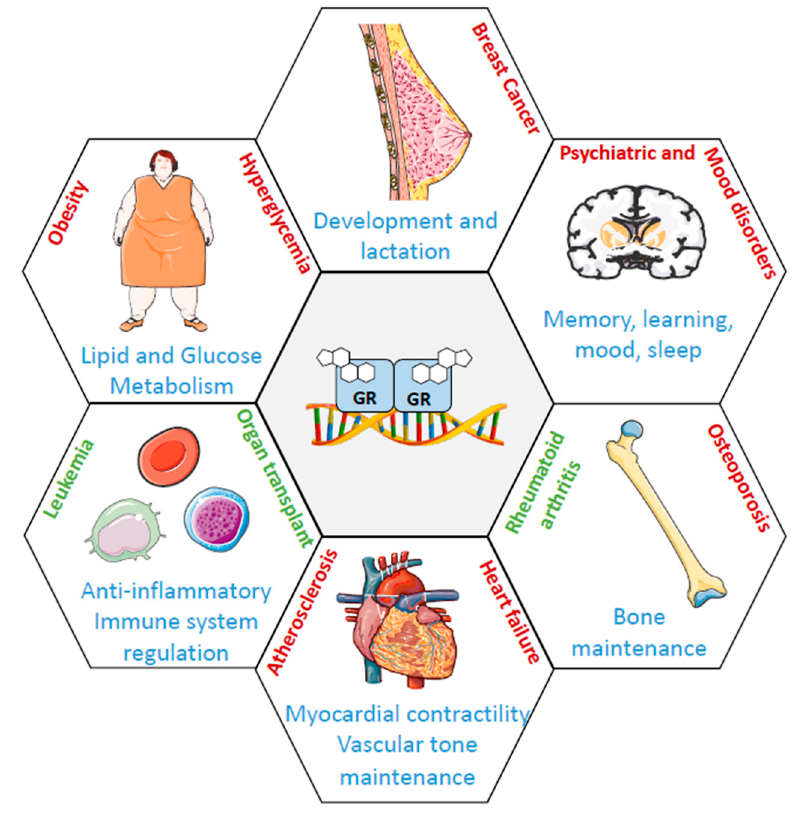
Figure 3. GR involvement in human health and disease. The schematic diagram represents the roles of GR in major systems (blue label) with beneficial roles of synthetic GCs used in clinics (green label) and adverse effects of GCs (red label).